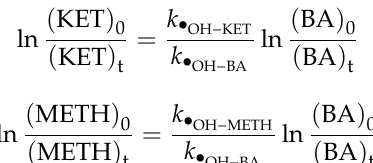
Figure 3. Photoluminescence (PL) spectral changes observed in the UV/H 2 O 2 system in a 5 × 10 −4 M basic solution of terephthalic acid (excitation at 315 nm).